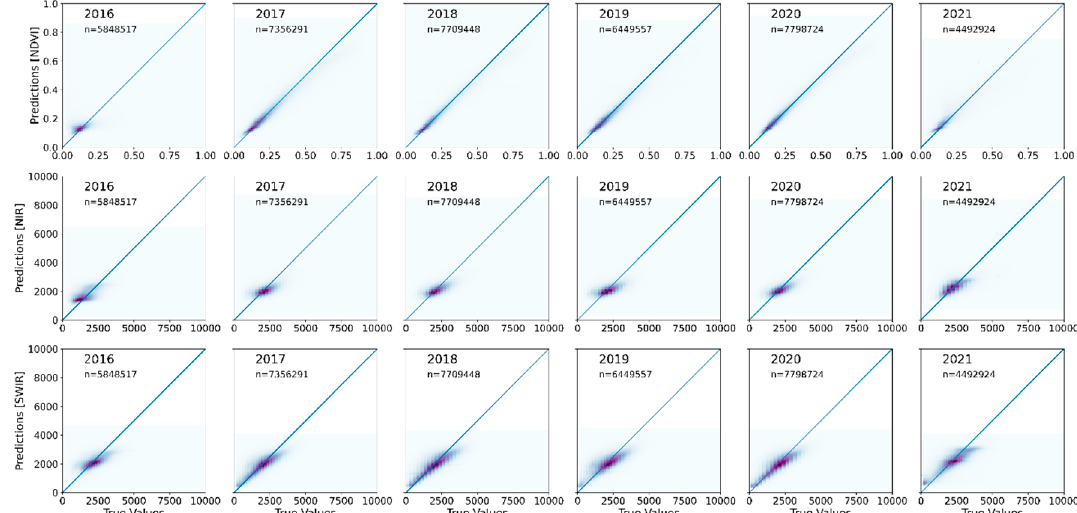
Figure 3. Model accuracies of the true values against the predicted values of independent samples for ( top ) Normalized Different Vegetation Index (NDVI); ( middle ) near infrared (NIR); and ( bottom ) shortwave infrared (SWIR) across the mapped years. Values (n) represent number of samples included to generate the two-dimensional histogram plots. The blue line indicates a 1:1 relation.